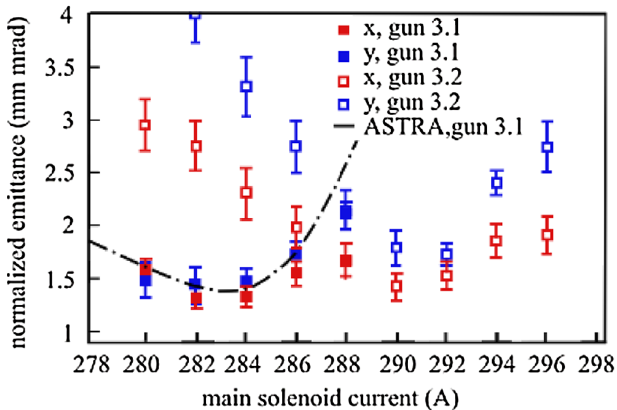
FIG. 30. (Color) The best emittance result from gun 3.1 in comparison with a corresponding ASTRA simulation and mea- surement from gun 3.2 for cathode gradients of around 40 MV = m . The applied machine parameters for each case are described in the text.